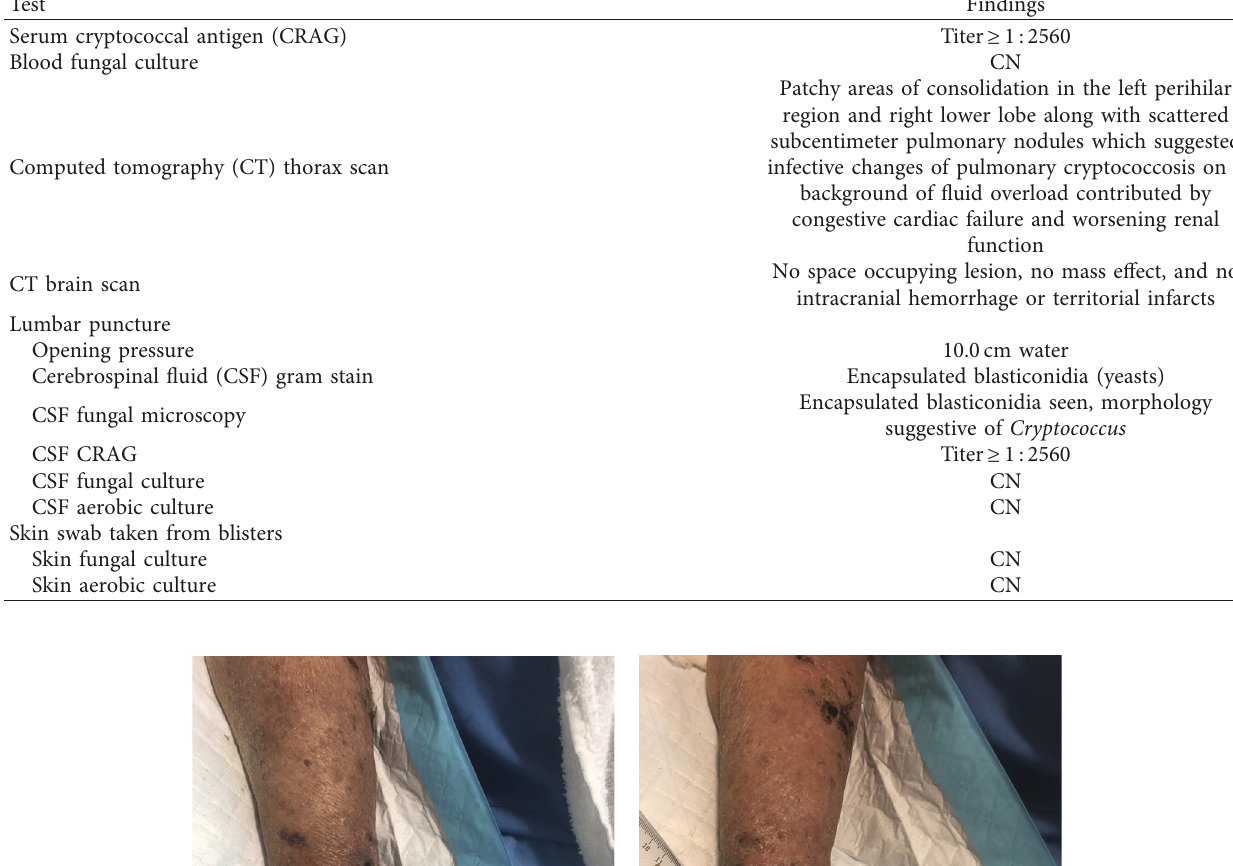
Table 2: Further investigations (day 7–10) leading to diagnosis of disseminated cryptococcosis.